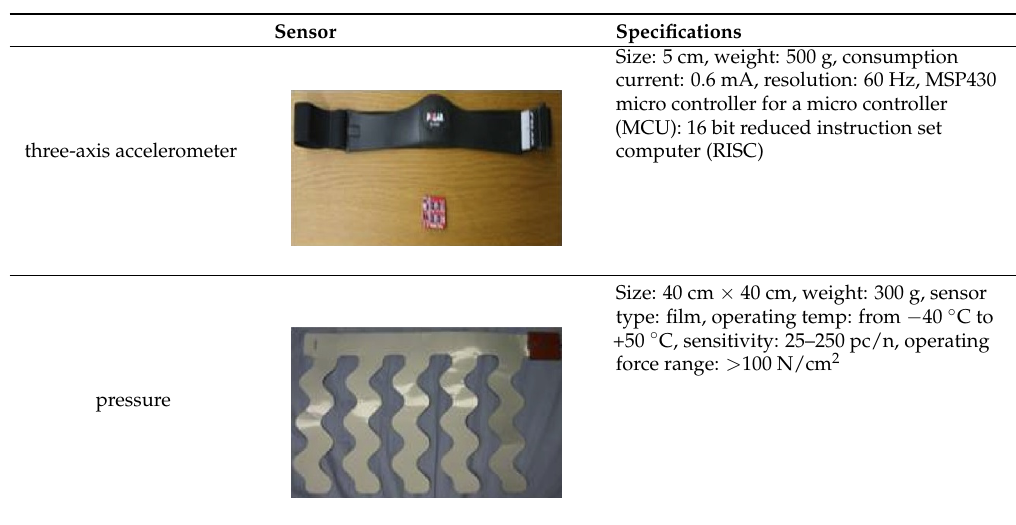
Table 1. Specifications of